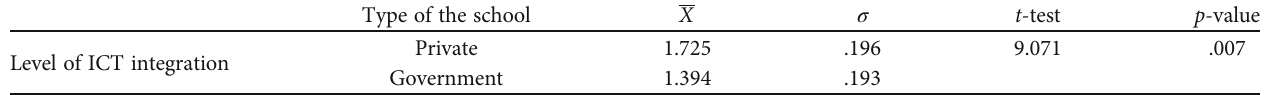
T ABLE 7: Independent samples test on the level of ICT integration in secondary